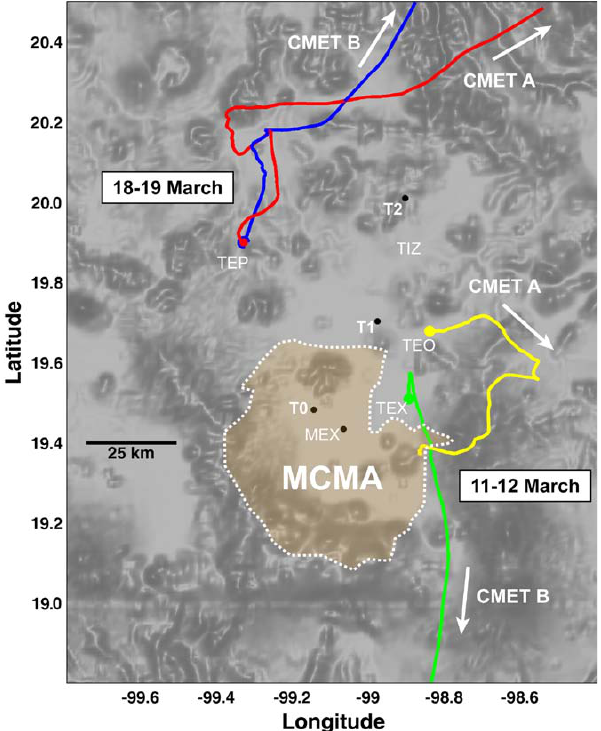
Fig. 3. Map of the Mexico City Metropolitan Area (MCMA) show- ing the research supersites (T0, T1, and T2), the approved CMET Figure 3. Map of the Mexico City Metropolitan Area (MCMA) showing the research 3 balloon launch sites (TEP, TIZ, TEQ, TEX), the Mexico City Air- port (MEX), and the initial portions of the CMET balloon trajec- supersites (T0, T1, and T2), the approved CMET balloon launch sites (TEP, TIZ, TEQ, TEX), 4 tories during two major MCMA outflow events (11–12 March and the Mexico City Airport (MEX), and the initial portions of the CMET balloon trajectories 5 18–19 during two major MCMA outflow events (11-12 March and 18-19 March). 6